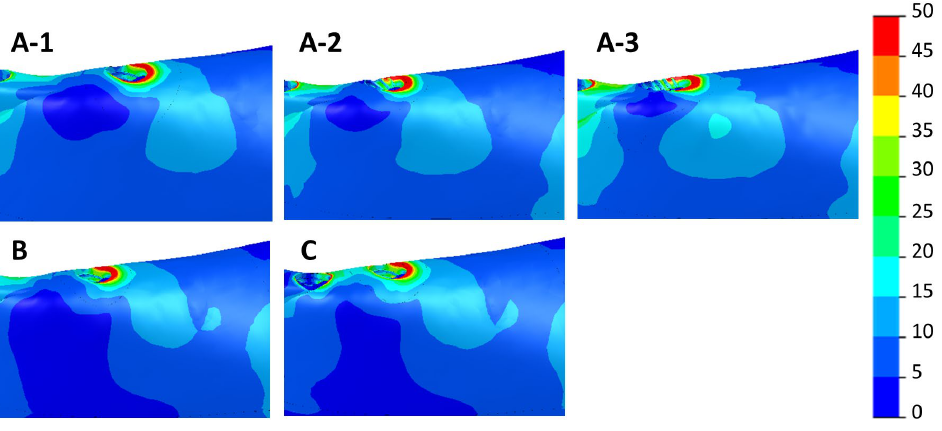
Figure 12. Distribution of the min. principal strain in scenarios with the two posterior implants moved distally to the foramina. Left—4 implants (D). Right—6 implants (E). moved distally to the foramina. Left—4 implants (D). Right—6 implants (E).